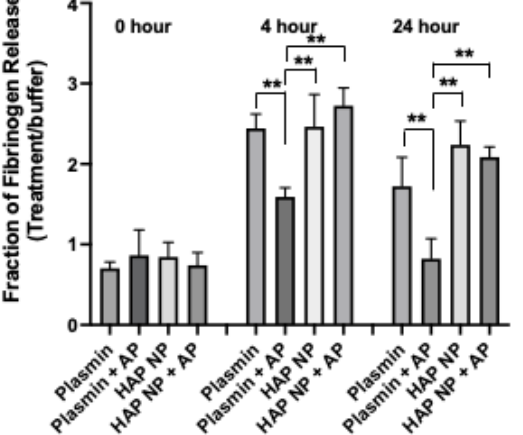
Figure 3. Fibrin clot lysis assay. Fibrin clot dissolution facilitated by nanoformulation and free plasmin with and without α 2-antiplasmin with equimolar ratios. Fibrin clots treated with plasmin nanoformulation (HAP NP), HAP NPs and α 2-antiplasmin (AP), free plasmin, free plasmin and AP, and clot lysis were measured at 0 h, 4 h and 24 h after treatment. n = 3 ± SEM, ** p < 0.01. To ensure HAP nanoparticles are safe to use in vivo, these particles were then tested for their toxicity and oxidative stress effects on brain endothelial cells. We used an apopto- sis/necrosis assay for the toxicity analysis since the normal metabolic toxicity assays were found not to be suitable for the study as the particles interfered with the reagent, resulting in very high metabolic readings (results not shown). As an alternative method, we used the apoptosis/necrosis assay to assess the live cells and death cell percentages due to HAP